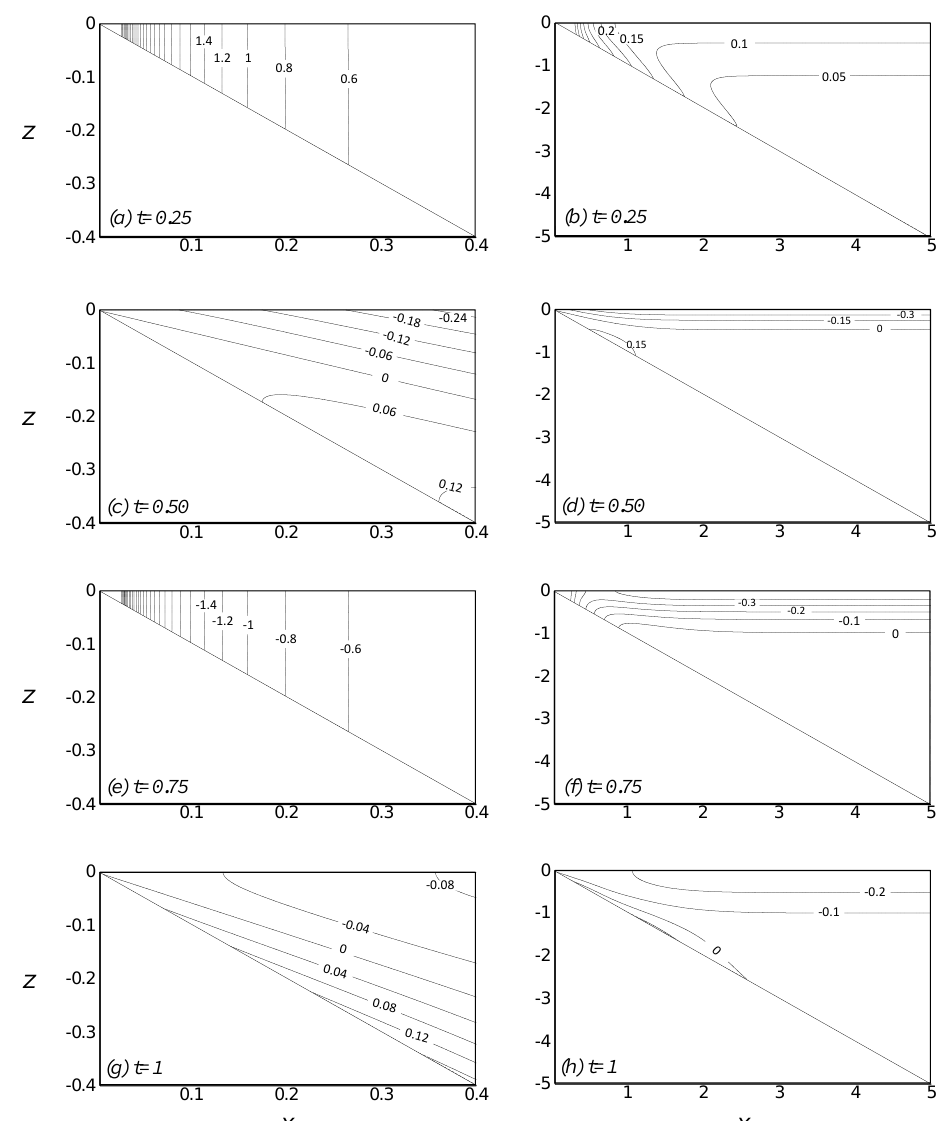
Figure 2. Temperature contours at z = 0.4 and 5 for various times. ( a , b ) t = 0.25, ( c , d ) t = 0.50, ( e , f ) t = 0.75, and ( g , h ) t =